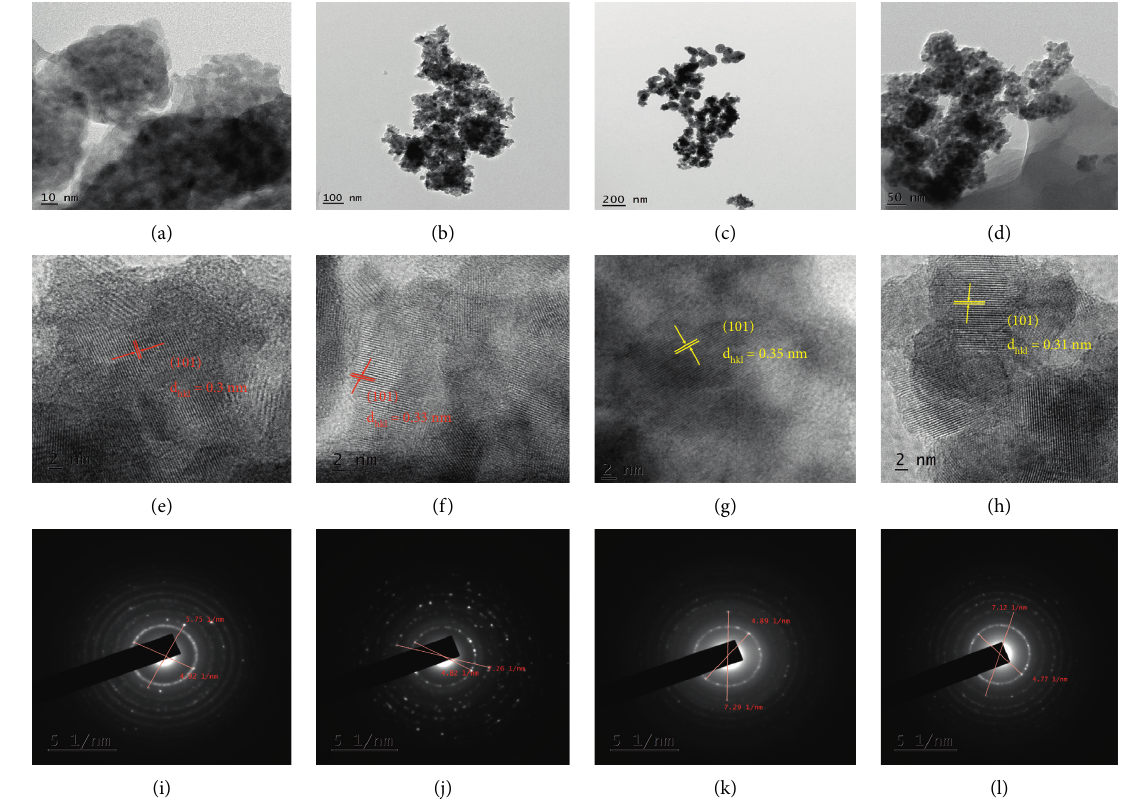
Figure 6: TEM image of TiO 2 / Citrus sinensis peel NPs (a), TiO 2 /rGO/ Citrus sinensis peel NCs (b), TiO 2 Musa acuminata peel NPs (c), and TiO 2 /rGO/ Musa acuminata peel NCs (d). HRTEM image of TiO 2 / Musa acuminata (e), TiO 2 / Citrus sinensis (f), TiO 2 /rGO/ Musa acuminata NCs (g), and TiO 2 /rGO/ Citrus sinensis NCs (h). SAED pattern of TiO 2 / Citrus sinensis (i), TiO 2 /Musa acuminata (j), TiO 2 /rGO/ Musa acuminata NCs (k), and TiO 2 /rGO/ Citrus sinensis NCs